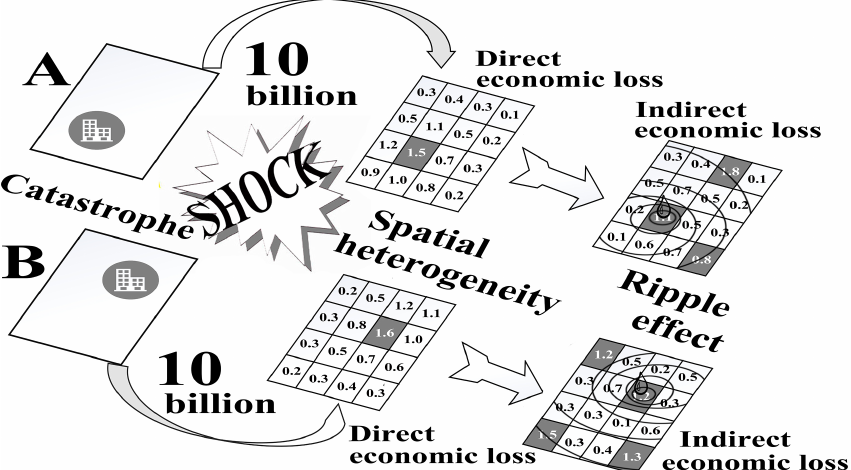
Figure 1. The diagrammatic representation of spatial heterogeneity and the ripple effects. A and B represent two disaster-hit areas with different functional zoning. If a catastrophe with the same intensity hits, both suffer a direct economic loss (DEL) of USD10billion, but the losses inside the areas are different due to functional zoning and the disaster’s location. The ripple effects of the indirect economic loss (IEL) are not only impacted by the distance of the occurring disaster; they are also impacted by the interregional and interindustrial